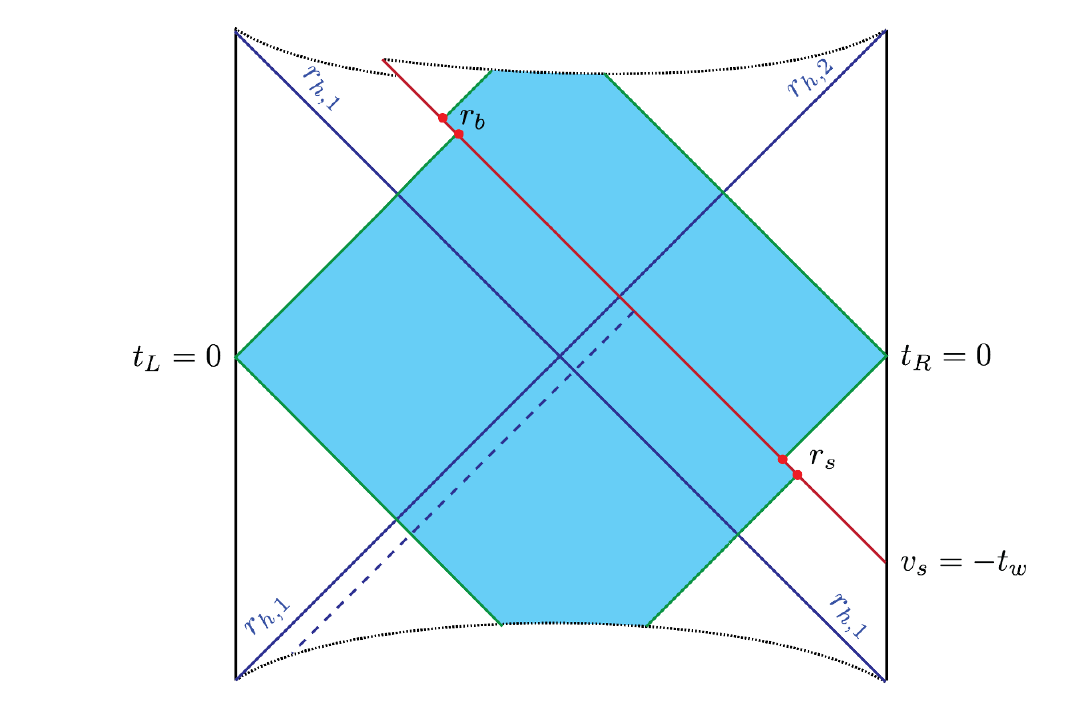
s = (cid:0) t w on an